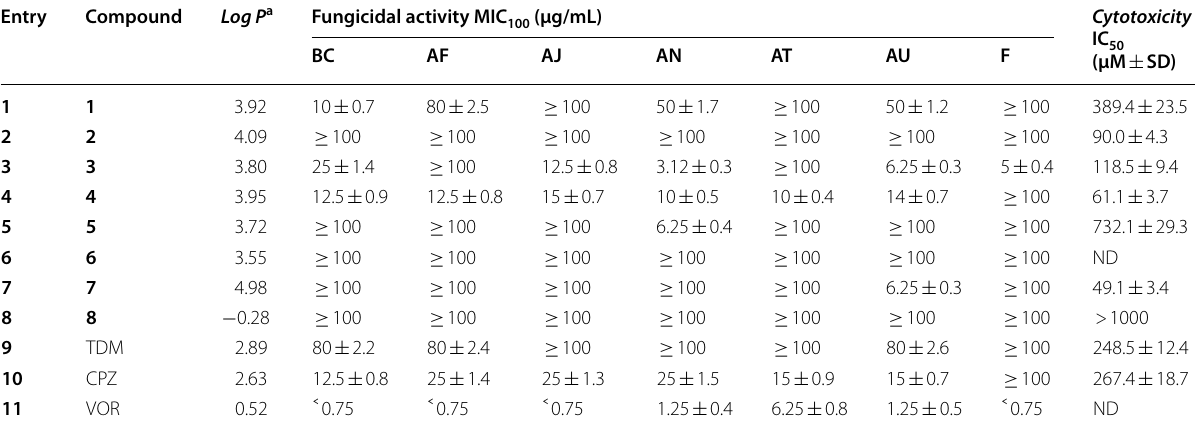
BC, B. cinerea (isolated from grapes); AF, Aspergillus fumigatus (ATTC 26934); AJ, A. japonicus (M15C); AN, A. niger (ATCC 9029); AT, A. terreus (M16C); AU, A. ustus (PN-S4); F, Fusarium oxysporum (M15-Pa). All strains were obtained from the culture collection of Instituto de Biotecnología, Universidad Nacional de San Juan (IBT). ND, Not determined. The log P values were estimated using ChemBioDraw Ultra 12.0